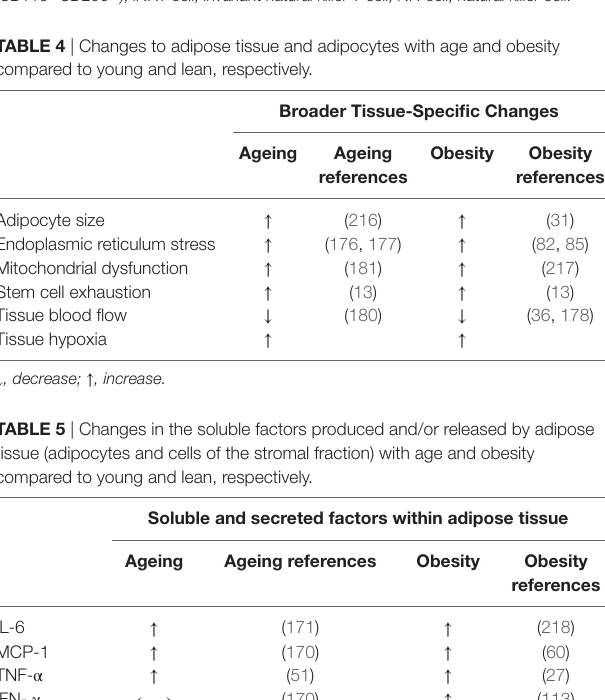
TABLe 4 | Changes to adipose tissue and adipocytes with age and obesity compared to young and lean, respectively.